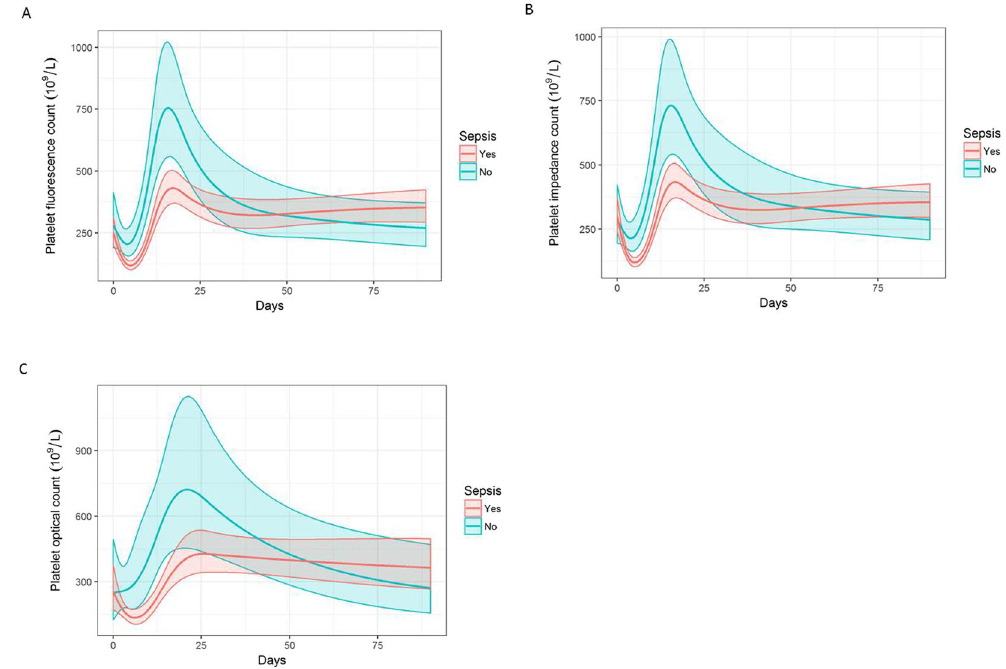
Figure 2. Platelet counts are different according to sepsis status. ( A ) Platelet fluorescence count (PLT-F) across time (n = 39). ( B ) Platelet impedance count (PLT-I) across time (n = 39). ( C ) Platelet optical count (PLT-O) across time (n = 39). Longitudinal analyses were performed using linear mixed-effects models to examine the relationship between time and platelet counts according to sepsis status (n = 39). Line represents predicted mean fixed effects; shaded area represents 95% confidence